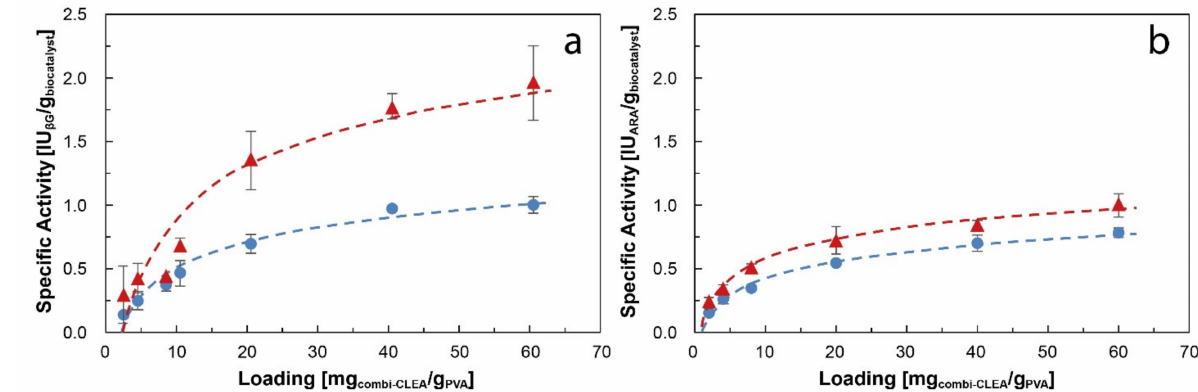
Figure 2. Effect of combi-CLEAs loading in polyvinyl alcohol lens-shaped particles on the expressed specific activity of ( a ) β G and ( b ) ARA, in PVA particles of two sizes: ( ) 2.6 mm average diameter and ( ) 6.0 mm average diameter. Results are presented as mean ± margin of error, n =